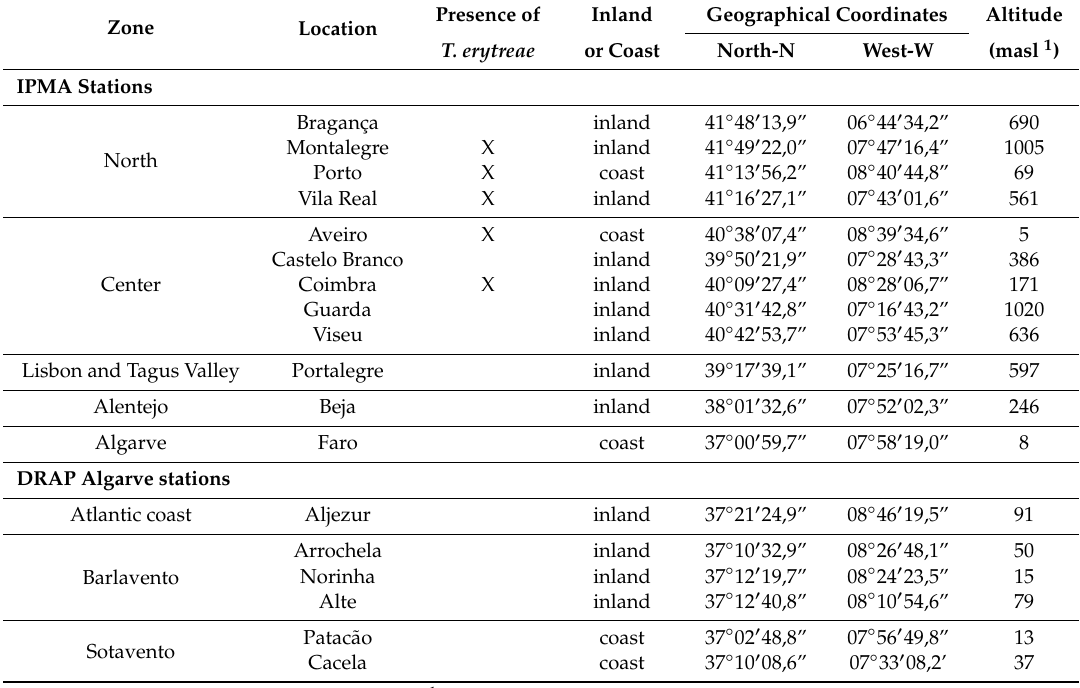
1 Meters above sea